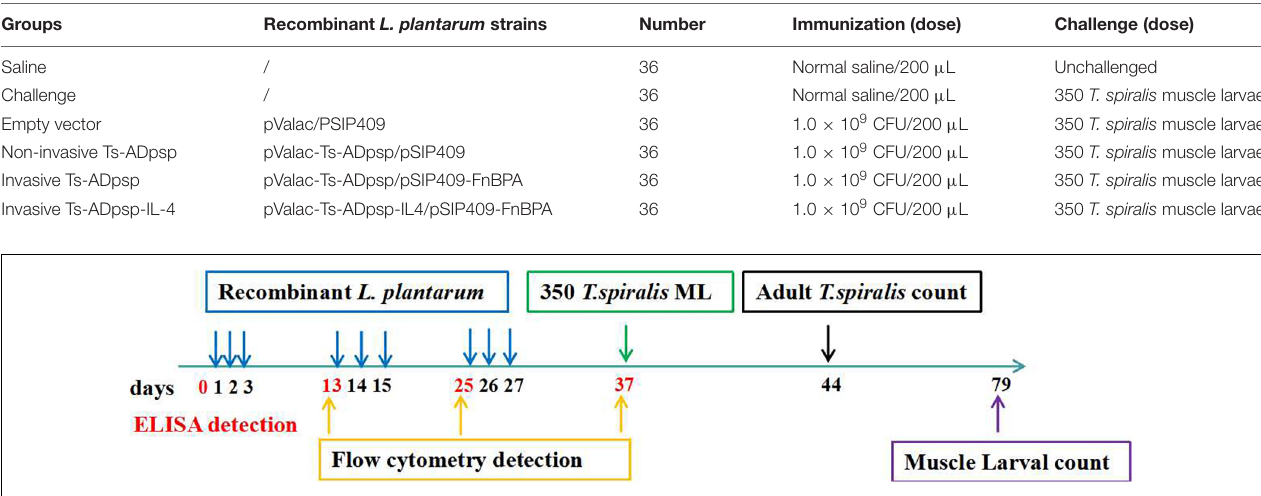
FIGURE 9 | Immune procedures. The immune-stimulation was carried out three times (1, 2, 3; 13, 14, 15; 25, 26, 27) at a 10-day interval and orally administered with 350 T. spiralis muscle larvae at day 37 after the first immunization. The ELISA detection was performed at days 0, 13, 25, 37 after the first immunization to detect the humoral immunity and mucosal immune response induced by recombined L. plantarum pValac-Ts-ADpsp-IL-4/pSIP409-FnBPA. The flow cytometry was carried out at days 13, 25, 37 after the first immunization to assess the cellular immune response. Adult worm was counted at days 44 after the first